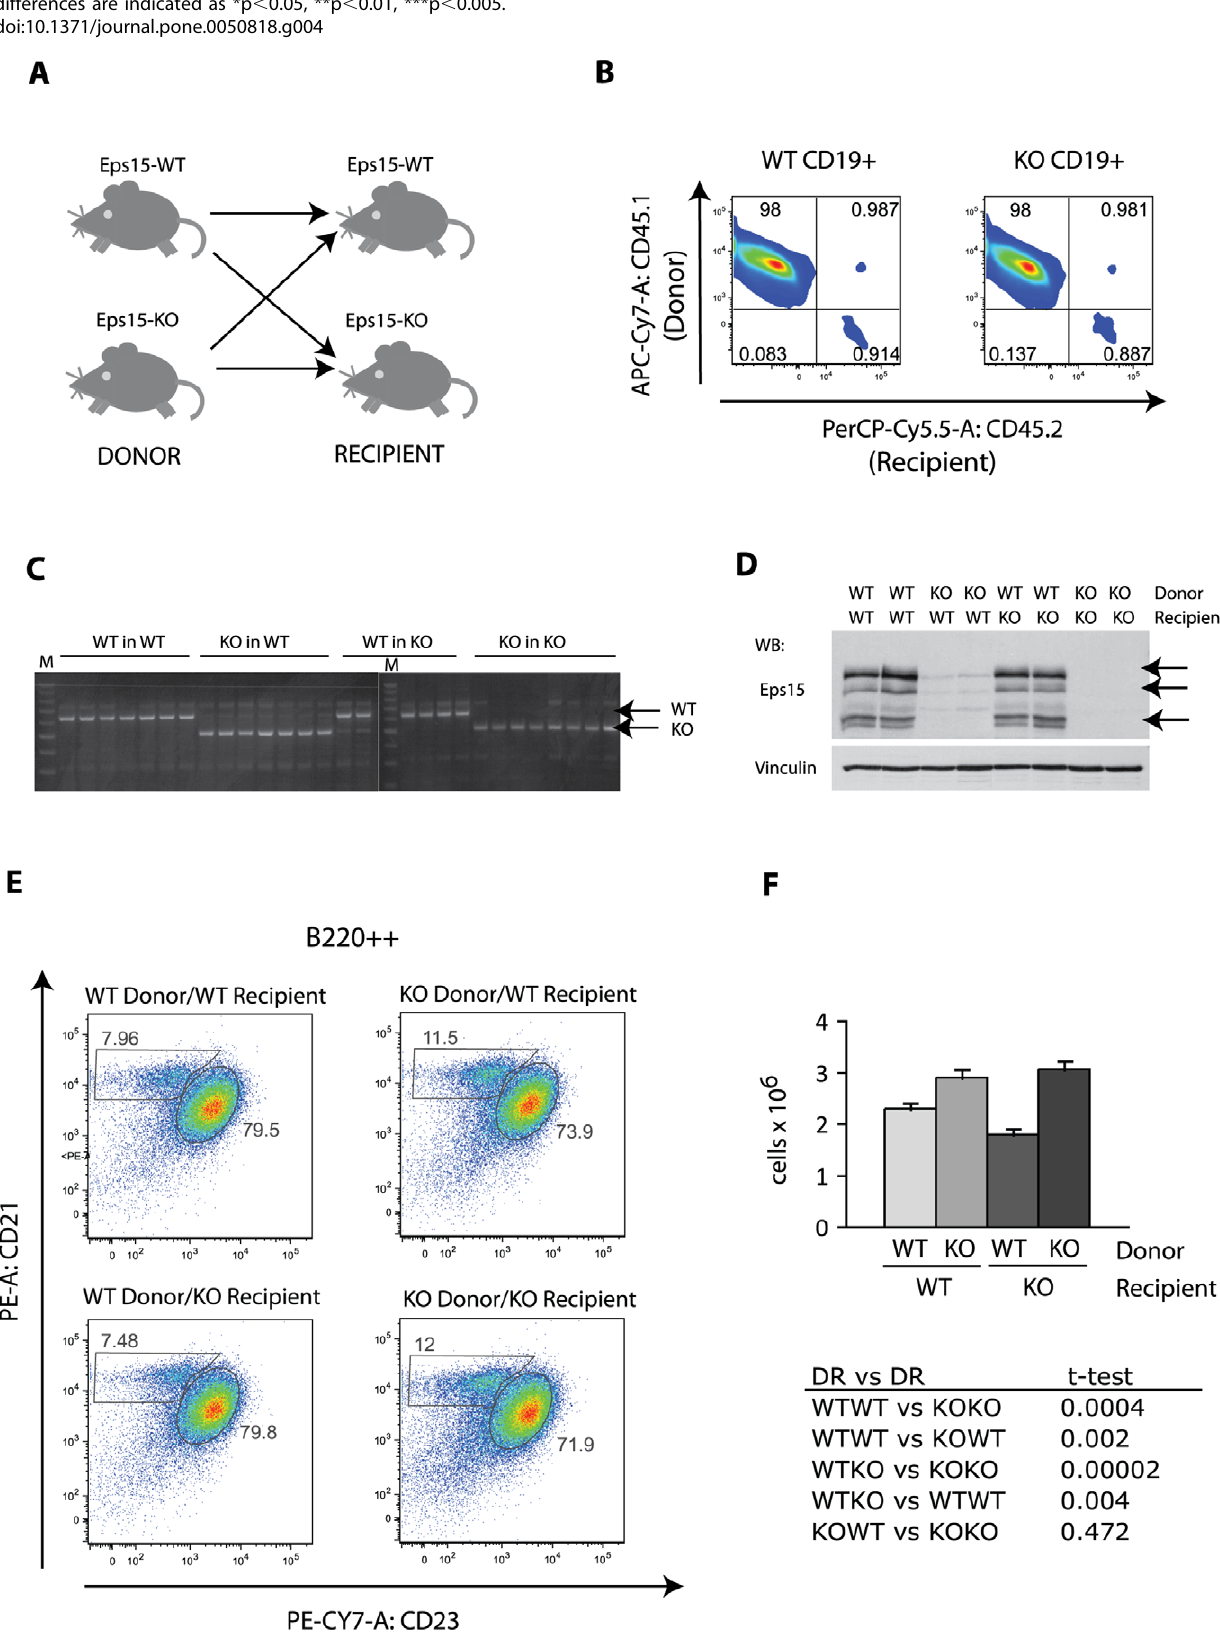
bars) and Eps15-KO (KO, black bars) mice (n=5). G. Dot plots of splenocytes from Eps15-WT and Eps15-KO mice stained for CD19, IgD and IgM to identify Fo B (CD19 + /IgD + IgM Low ), MZ B plus T1 transitional B (MZ B + T1, CD19 + /IgD low/ 2 IgM + ) and T2 transitional B (CD19 + /IgD + IgM + ) cells. H. Bar graph depicting total cell numbers of Fo B, MZ B + T1, and T2 transitional B cells in the spleens of Eps15-WT (WT, white bars) and Eps15-KO (KO, black bars) mice (n=5). Values are depicted as mean 6 standard error mean. Statistical significance was assessed using Student’s t-test and significant differences are indicated as *p , 0.05, **p , 0.01, ***p , 0.005.